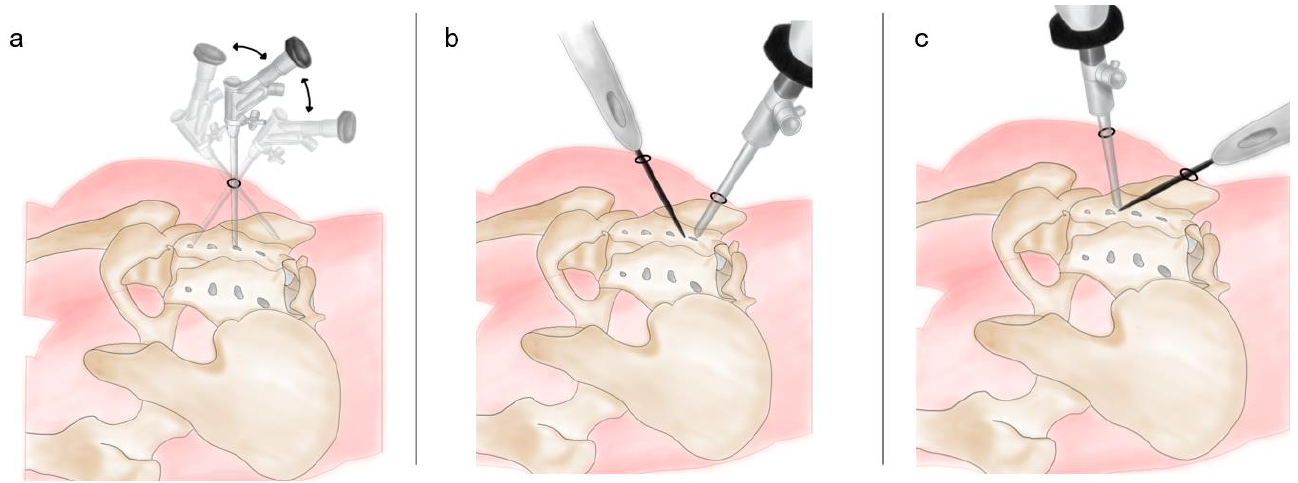
Figure 5. Biportal endoscopy allowed us to improve the working angle by switching the viewing endoscope and the ablation wand. ( a ) Single-port endoscopy has a limited working angle that restricts operating at the S3 lateral branch and L5 dorsal ramus. ( b , c ) Biportal endoscopy afforded a more flexible working space by allowing us to exchange the viewing endoscope and the ablation wand.